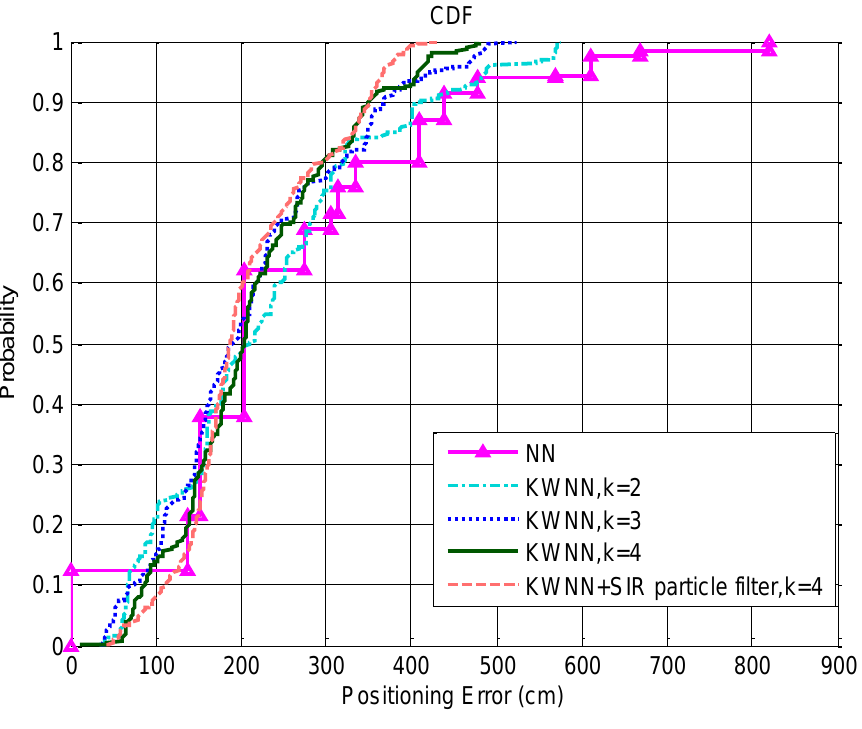
Figure 10. The CDFs of the positioning errors by various matching